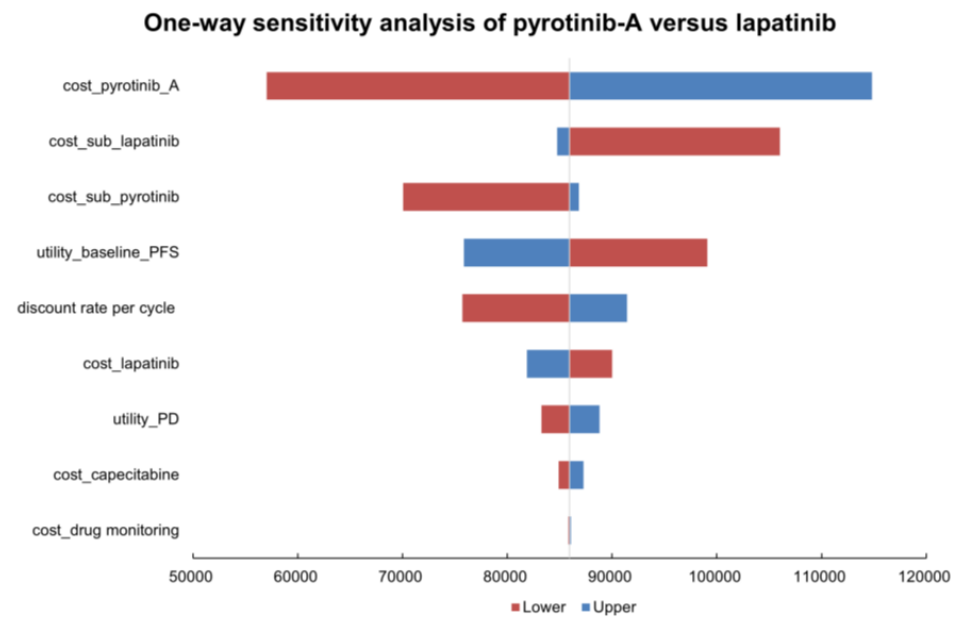
Figure 3. Tornado diagram for one-way sensitivity analysis of pyrotinib-A plus capecitabine versus lapatinib plus capecitabine. Abbreviations: pyrotinib-A, pyrotinib before being enrolled in National Reimbursement Drug List; PFS, progression-free survival; PD, progressive disease; sub, subsequent.